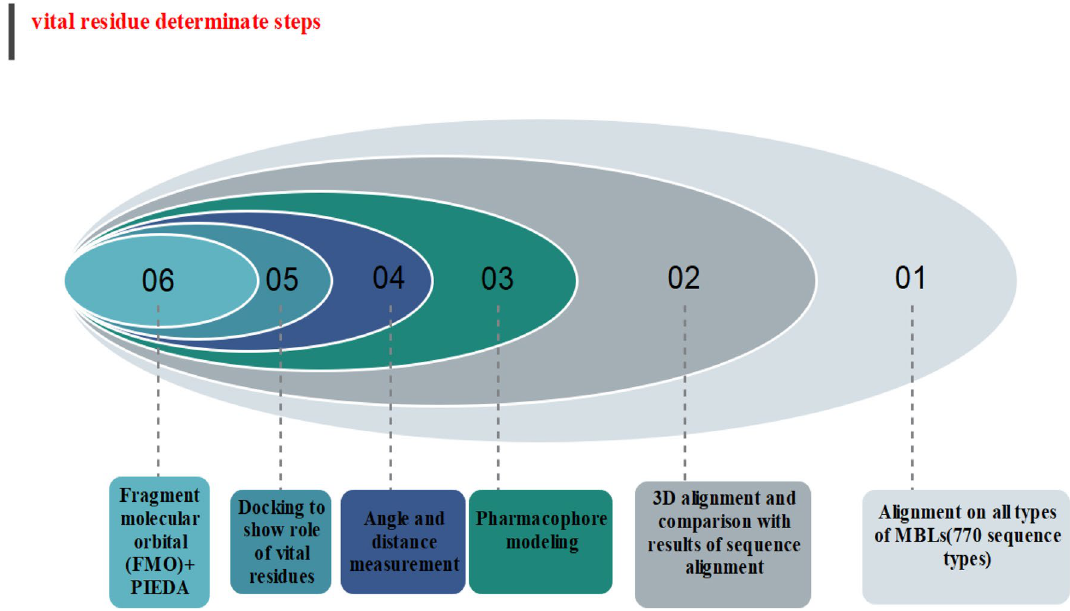
Figure 2. Common pharmacophore and conserve key amino acids in active site of all MBLs subclasses were found via pharmacophore modeling, 3D conformational alignments, protein sequence alignments over MBLs subtypes (more than 700 subtypes) and assessment of distances, angles between crucial amino acids. Comparison of these data showed common pharmacophore and key amino acids among all class of MBL was matchable and compatible. In order to confirm the efficacy of above data, biapenem was docked in the three classes of MBL. Docking and post docking process showed key residues had involved in the docking and all three docking results had common pharmacophore. FMO is the uttermost of assessment to vouch and confirm achievement of other